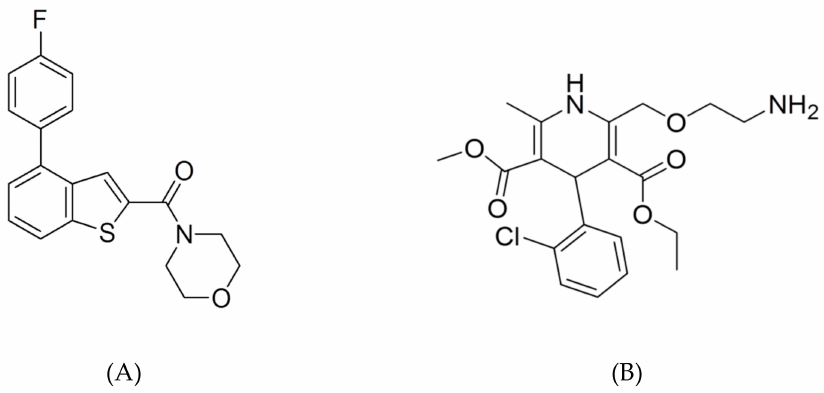
Figure 10. Chemical structures of CK41016 ( A ) and amlodipine (IS) ( B